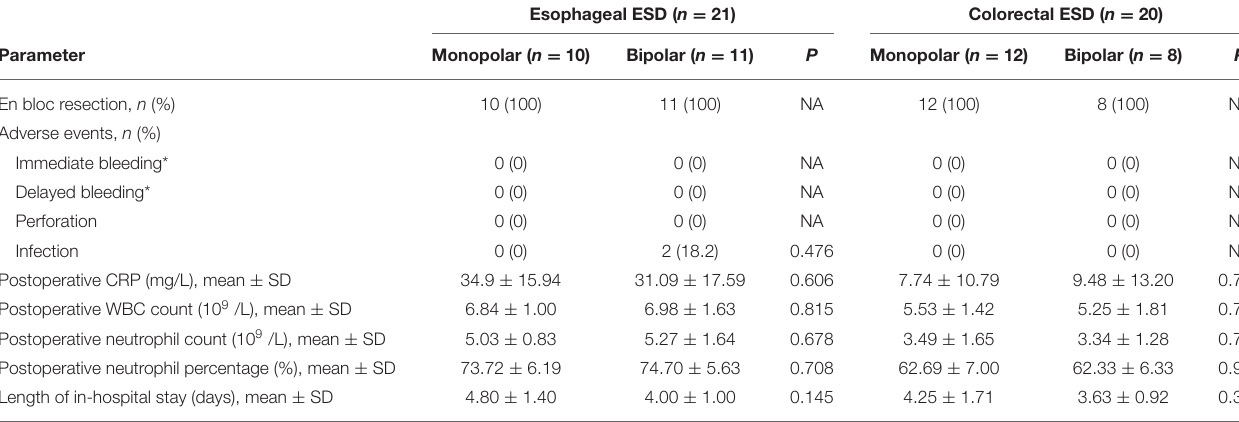
TABLE 5 | Outcomes and adverse events of patients after ESD in monopolar and bipolar groups.